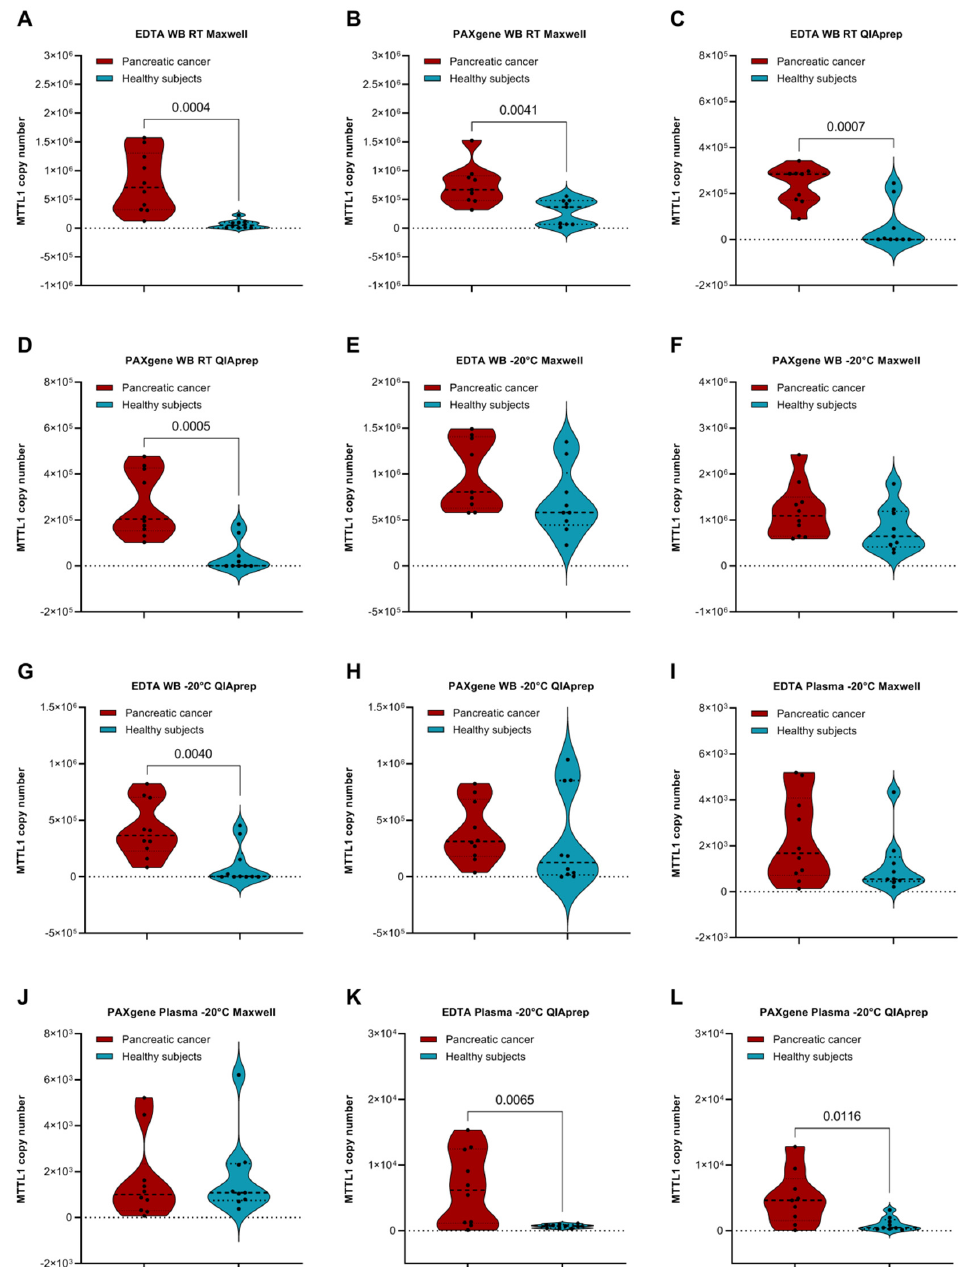
Figure 6. Comparison of mtDNA levels in pancreatic cancer patients vs. healthy subjects under various preanalytical conditions. Comparison of mtDNA copy number present in whole blood samples of healthy subjects vs. cancer patients stored in EDTA vs. PAXgene tubes at RT for 3 h prior to processing, followed by mtDNA isolation with ( A , B ) the Maxwell Kit and ( C , D ) the QIAprep Kit, as well as with storage of − 20 °C prior to processing, followed by mtDNA isolation with ( E , F ) the Maxwell Kit, and ( G , H ) the QIAprep Kit. Comparison of mtDNA copy number present in plasma samples of healthy subjects vs. cancer patients stored in EDTA vs. PAXgene tubes at − 20 °C prior to processing, followed by mtDNA isolation with the Maxwell Kit ( I , J ) and ( K , L ) the QIAprep Kit. Ten healthy subjects were recruited in each cohort. Outliers were identified and omitted using Grubb’s test (Alpha = 0.05). p -values lower than 0.05 indicate a statistically significant difference.